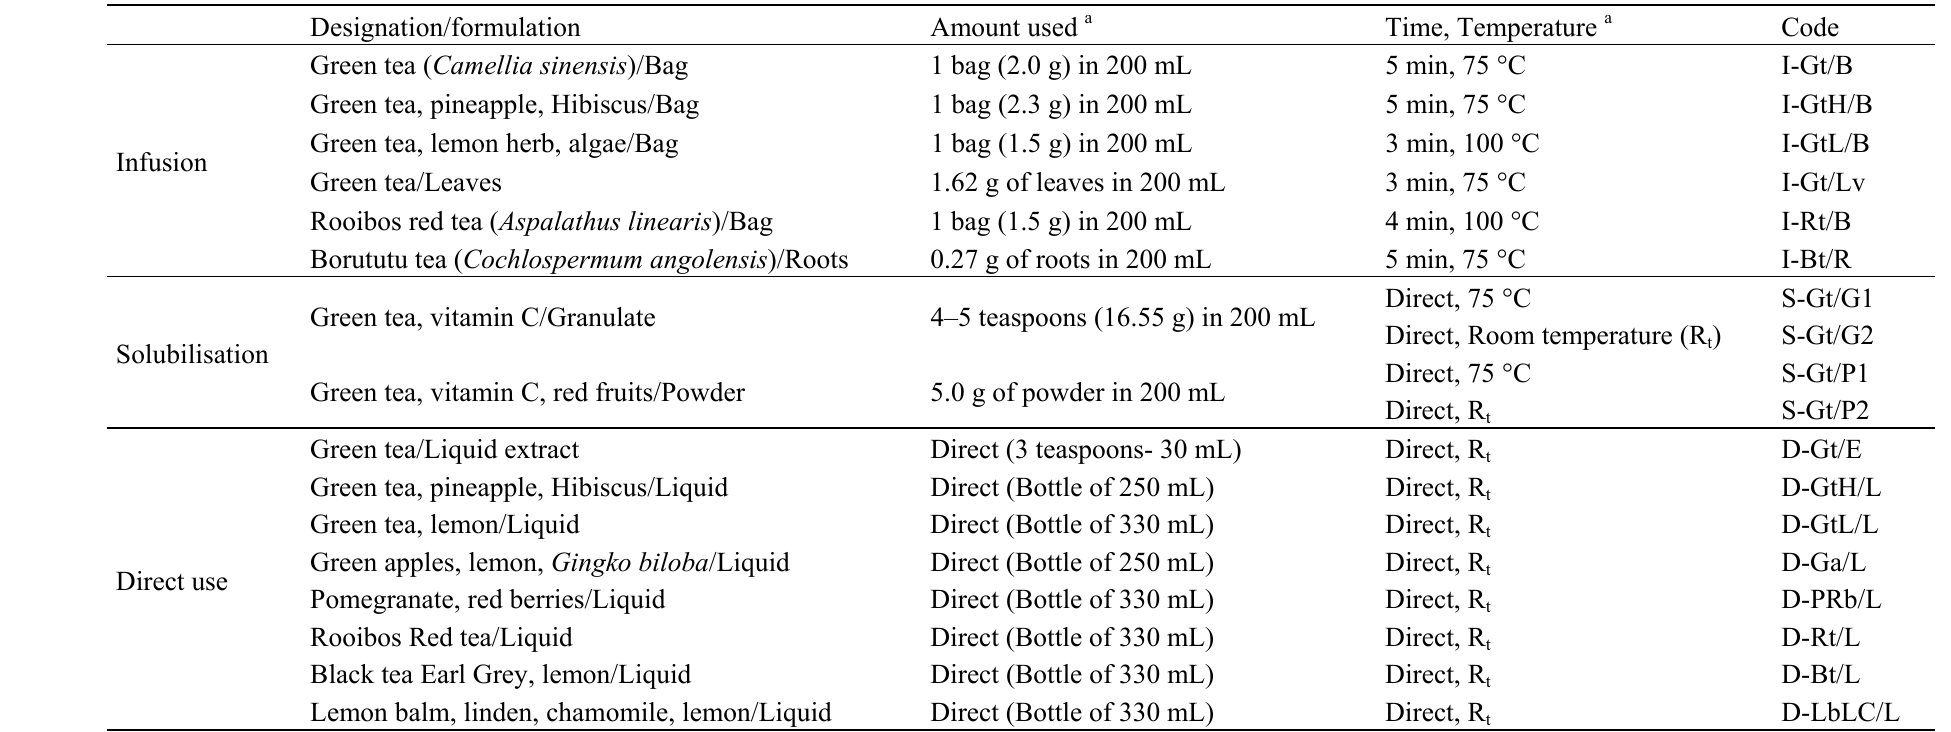
Table 2. Identification and preparation of the “teas” (stock